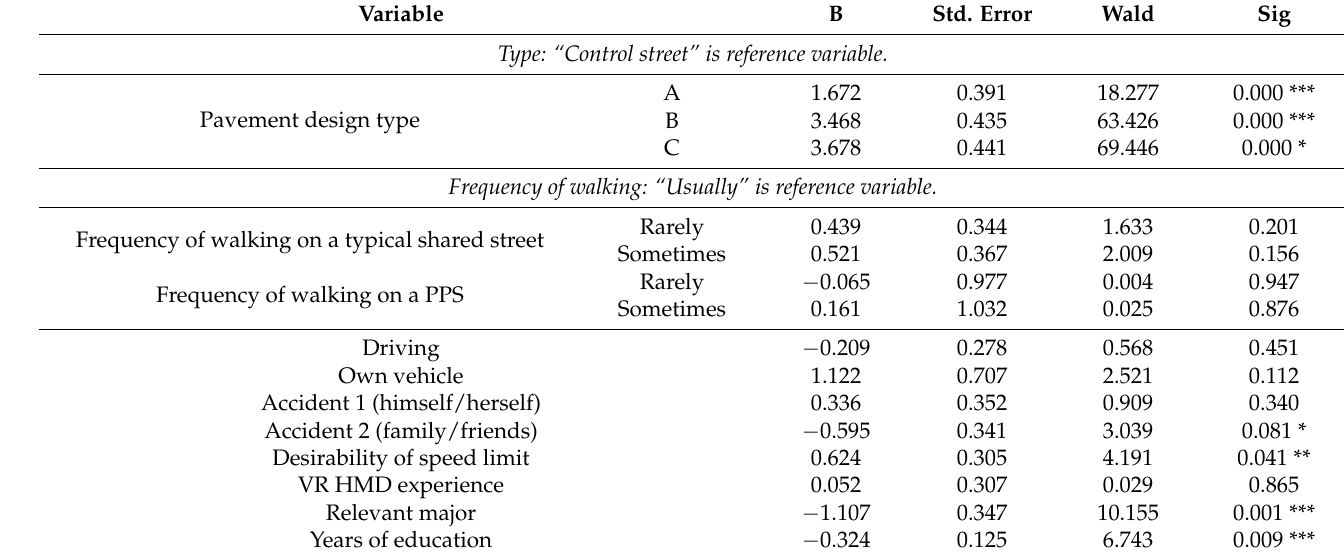
Table 5. Ordered Logit regression model of perceived safety. Variable B Std. Error Wald